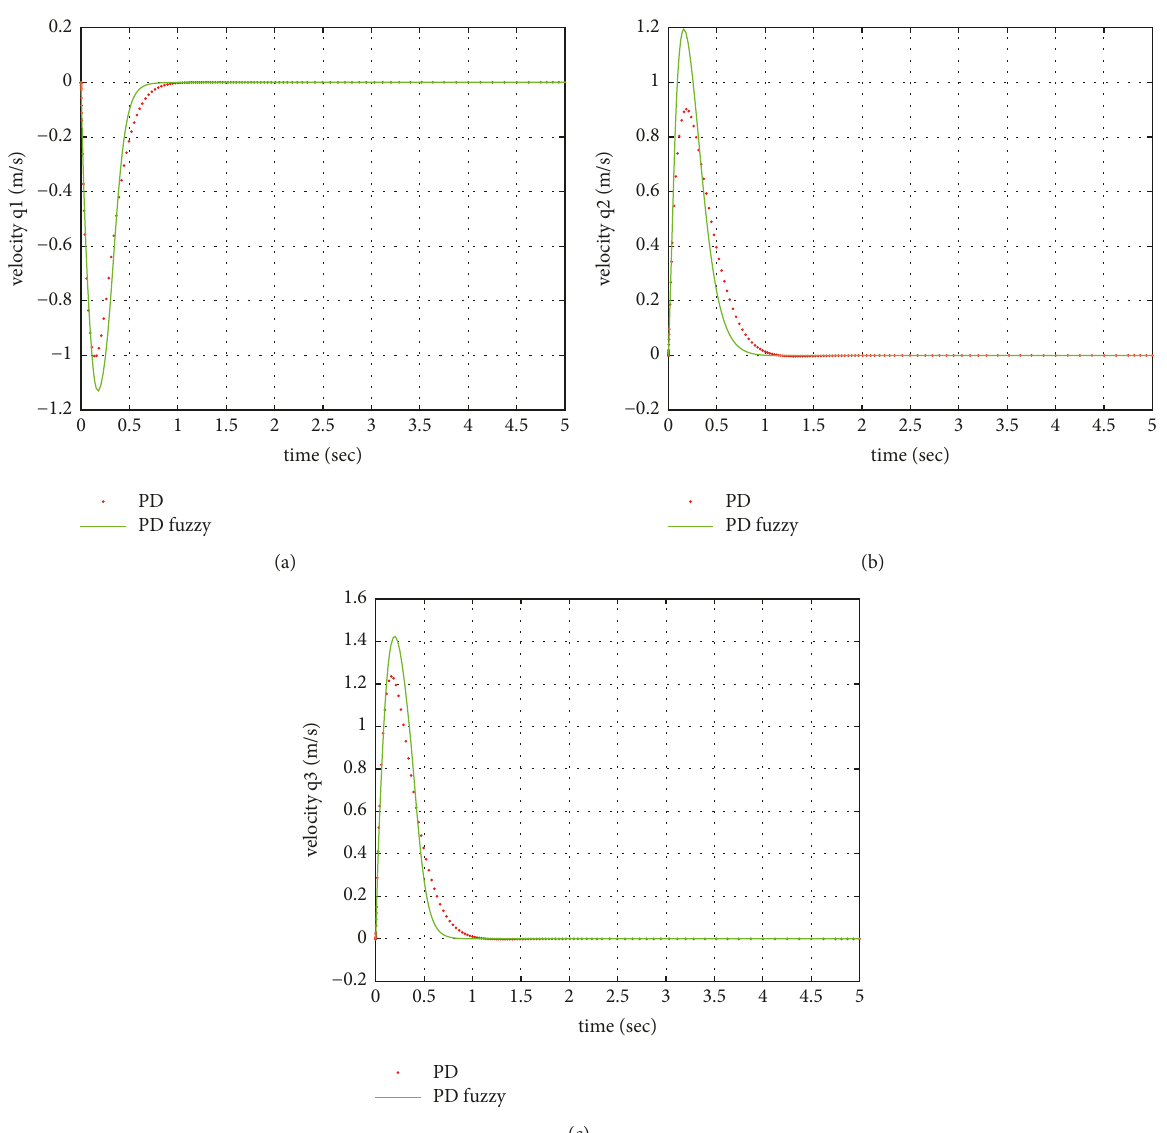
Figure 6: The comparison of the velocity diagrams, (a) the velocity of the first link (revolute), (b) the velocity of the second link (prismatic), and (c) the velocity of the third link